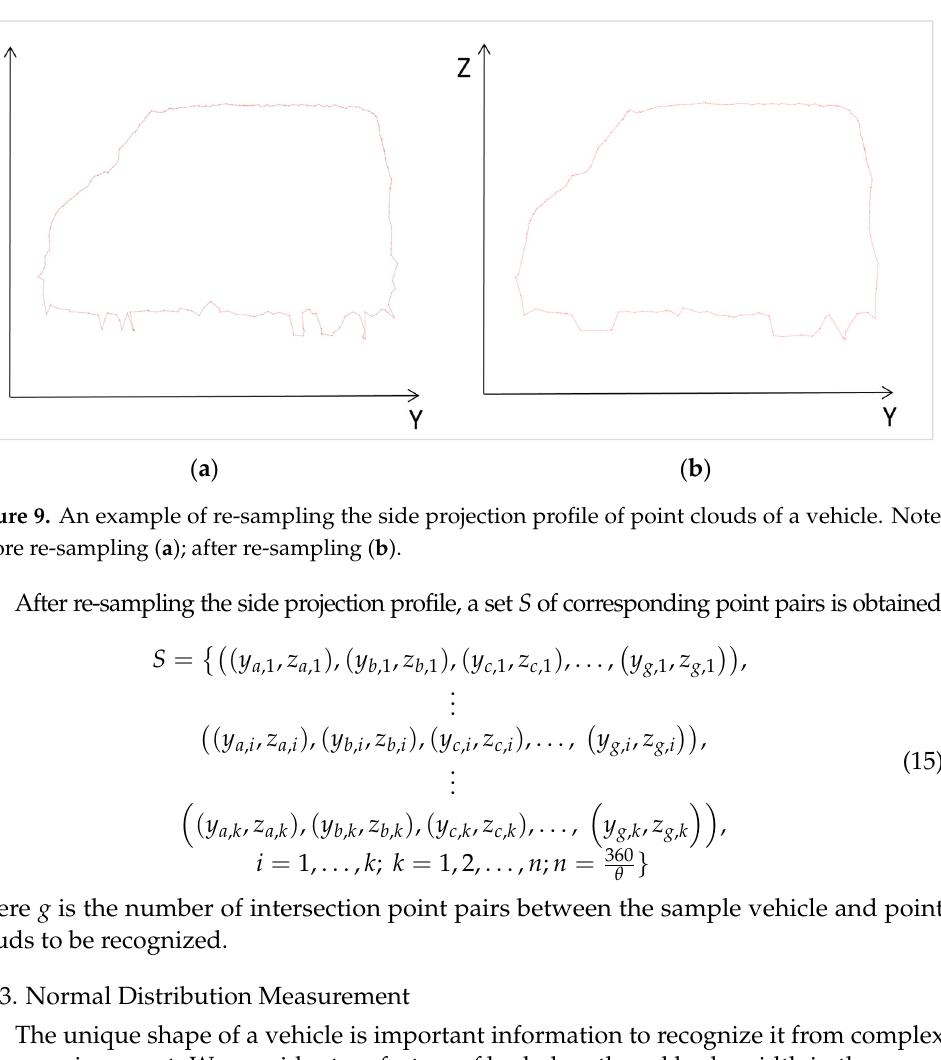
Figure 8. Selection of the corresponding point pairs.